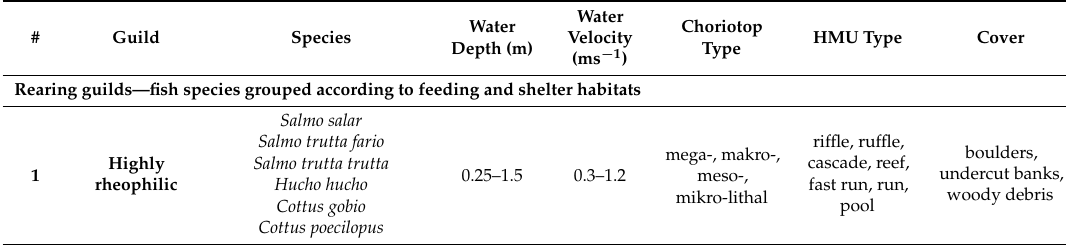
Table A1. Habitat-use guilds defined for river fauna in Poland, together with habitat-use criteria defined for each guild. The criteria highlighted in bold are critical, i.e., need to be fulfilled for habitat to be suitable. The substrate types (choriotope) are according to Austrian Norm (ON